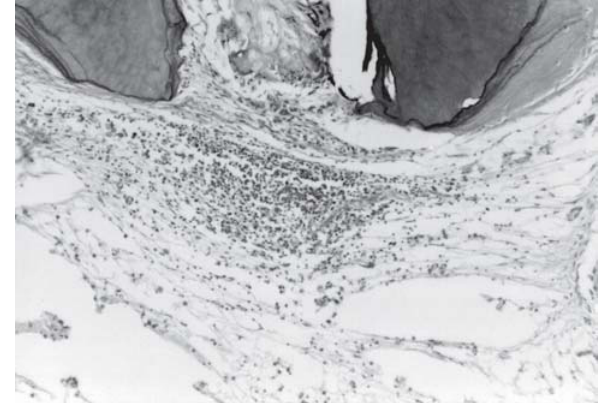
FIGURE 5- Group III – Metronidazole – No biological closure, partial repair of areas of cemental resorption and an intense chronic inflammatory infiltrate in the periodontal ligament. H.E., 100X